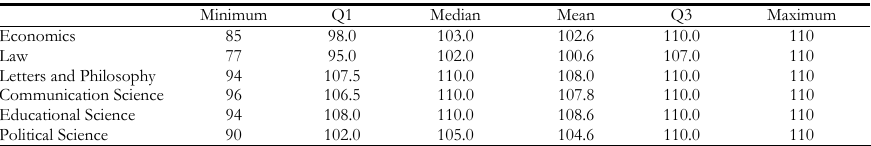
Descriptive statistics of the degree marks by Faculty